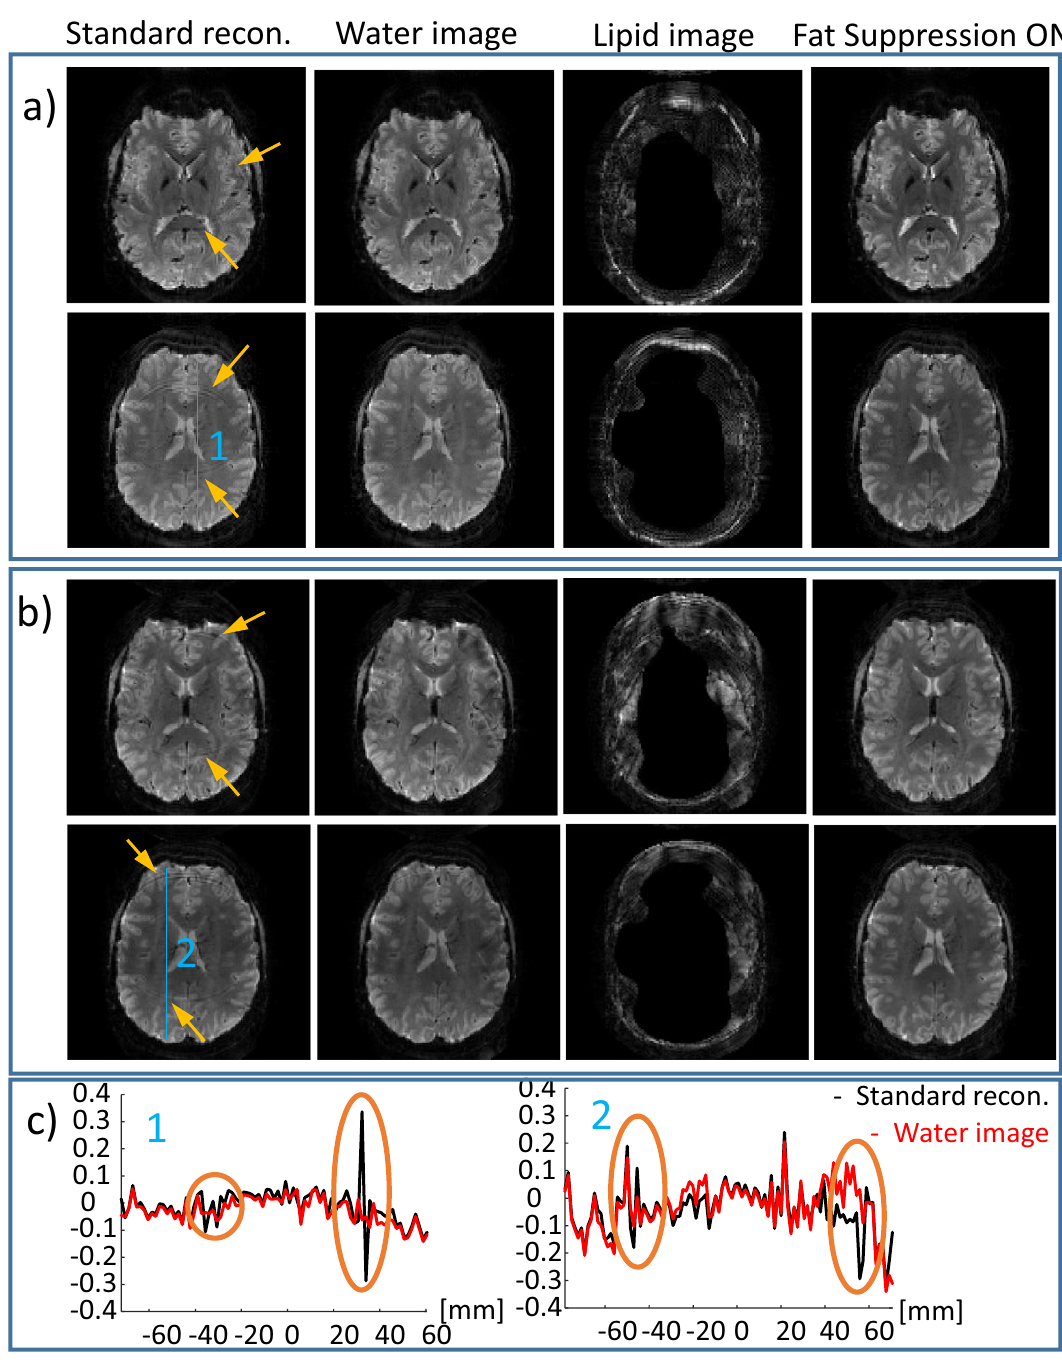
Figure 4. Human imaging – combined in-plane acceleration and lipid-water reconstruction. Two representative slices are shown for R PE = 2 ( a ) and R PE = 3 ( b ). From left to right–standard recon. (Siemens product reconstruction), water image, and lipid image from scan without fat suppression, and the image acquired with fat suppression. ( c ) Relative signal change ( lines (1) and (2) shown in ( a ) and ( b ), respectively. Yellow arrows point to the artifact due to the lipid signal in the standard